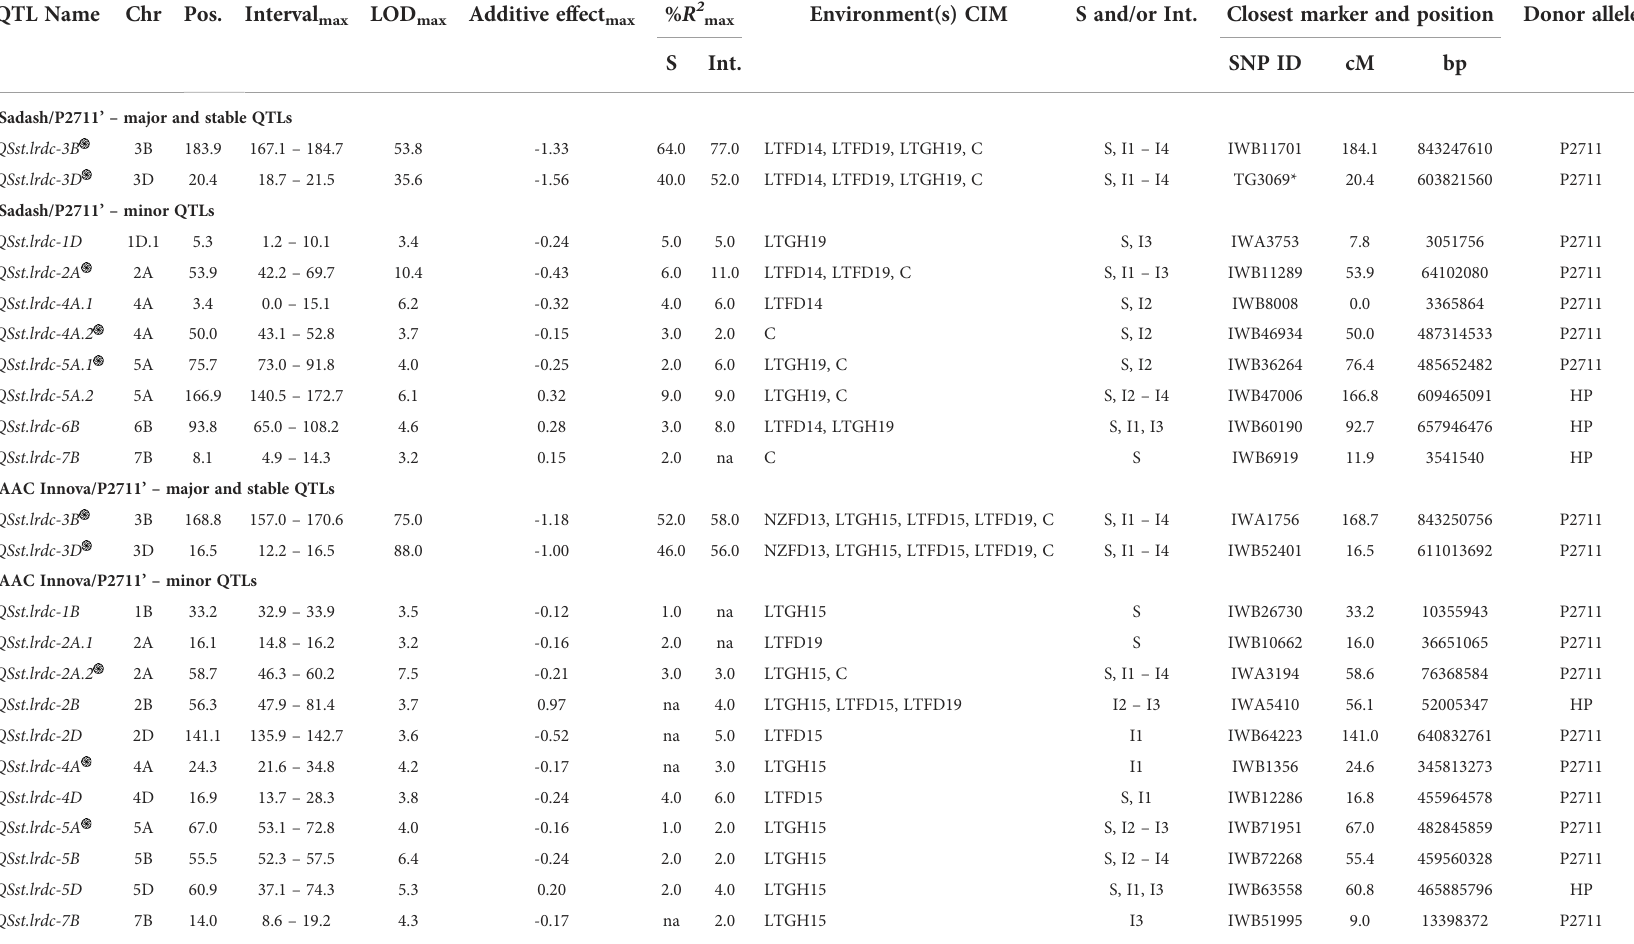
TABLE 1 Summary of quantitative trait loci (QTLs) identi fi ed for stem solidness in ‘ Sadash/P2711 ’ and ‘ AAC Innova/P2711 ’